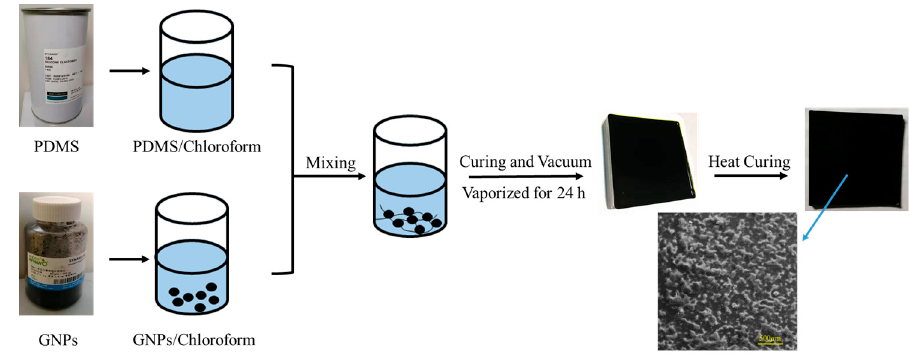
Figure 1. Process for the fabrication of graphene and polydimethylsiloxane (GNP/PDMS) nanocomposites.